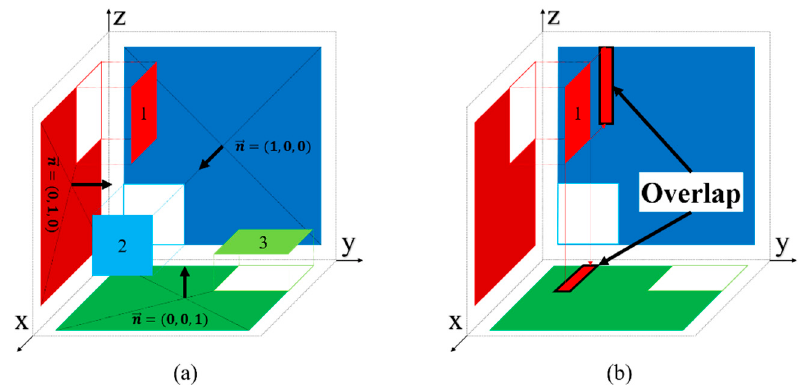
Figure 11. ( a ) Candidates of structural members; ( b ) Overlap between candidates.